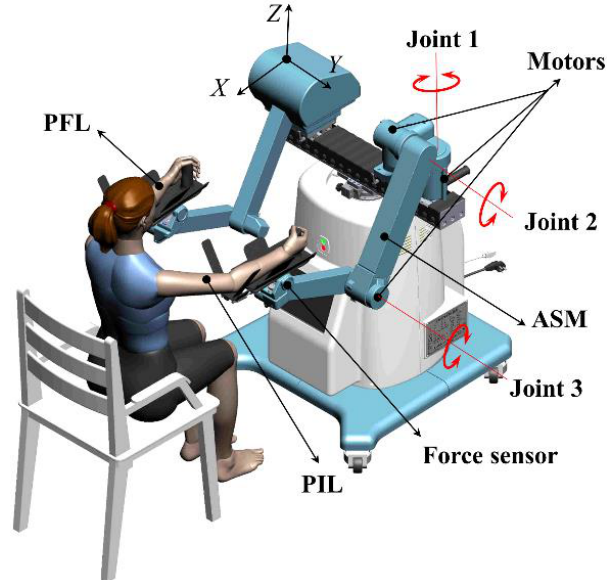
three degrees of freedom. The robotic arms can move in a three-dimensional workspace. A schematic diagram of the upper limb bilateral rehabilitation robot is shown in Figure 1. The ASM with three joints is the control object in this paper.